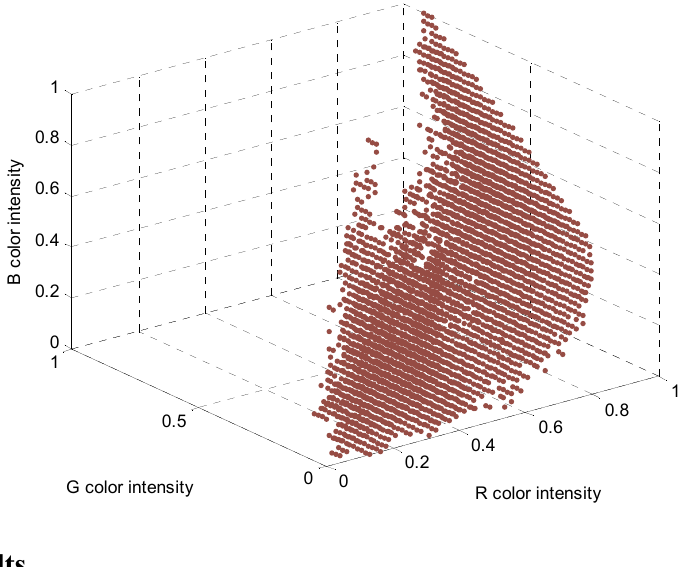
Figure 5. Red peach segmentation LUT obtained from a three-dimensional